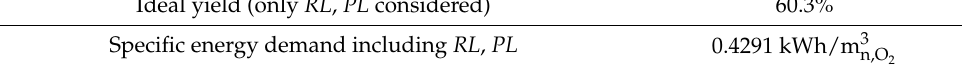
input exceeds the exergy content of the product. Table 5. Process conditions and energy demand of the ideal Pressure Swing Adsorption. Quantity Value and Unit Demand for isothermal compression of dry air (1 to 6 bar, 20 ◦ C) 0.2587 kWh/m 3 Ideal yield (only RL , PL considered) 60.3% Specific energy demand including RL , PL 0.4291 kWh/m 3